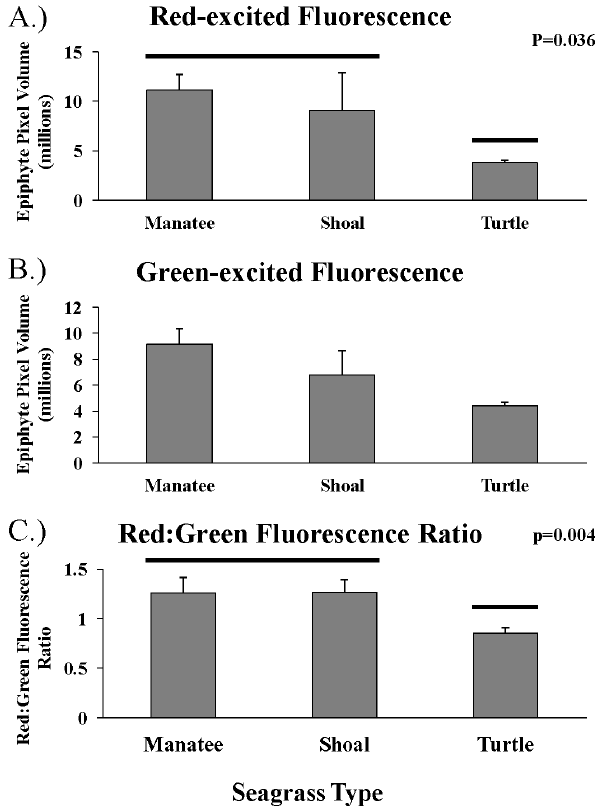
Figure 2. Mean epiphyte pixel volume ( + SE) standarzied to seagrass leaf surface area (247 mm 2 ), detected by flourometry among 3 seagrass species. A) red-excited fluorescence B) green- excited fluorescence and C) ratio of red to green fluorescence. Red-excited fluorescence detects all photosynthetic organisms, green- excited fluorescence detects primarily red algae but also diatoms and some cyanobacteria. aztecus ), arrow shrimp ( Tozeuma carolinense ), mud crabs (Xanthi- dae), blue crabs ( Callinectes sapidus ), and Callinectes spp. (Table 5). Total density of all combined species was highest in manatee grass (F 15,59 = 6.05, p , 0.01), and significant pairwise differences were detected with Tukey’s HSD test. Shrimp had the highest density of any group and were most abundant in manatee grass (F 15,59 = 7.01, p , 0.01), which accounted for the overall highest density of organisms in manatee grass. Fish had highest density in shoal grass (F 15,59 = 8.87, p , 0.001), and crabs had the highest density in turtle grass (F 15,59 = 13.93, p , 0.001). Three groups: blue crabs (F 15,59 = 12.41, p , .001, Figure 6), gobies (F 15,59 =8.98, p , 0.001), and Penaeidae (F 15,59 =15.16, p , .001, Figure 7) had highest density in shoal grass. Arrow shrimp had significantly higher density in manatee grass (F 15,59 =107.86, p , .001), and mud crabs had significantly higher density in turtle grass (F 15,59 = 16.30, p , 0.001). Pipefish and seahorses had lowest density in turtle grass but their density was not statistically different between manatee and shoal grass (F 15,59 = 5.16, p , 0.01). Brown shrimp had significantly lower density in shoal grass than in the other seagrass habitats (F 15,59 = 9.10, p , 0.001). Of the groups investigated, only grass shrimp ( Palaemonetes sp. , F 15,59 =0.72, p = 0.49) and red drum ( S. ocellatus , F 15,59 =0.93, p =0.40) did not show significant differences among seagrass species.